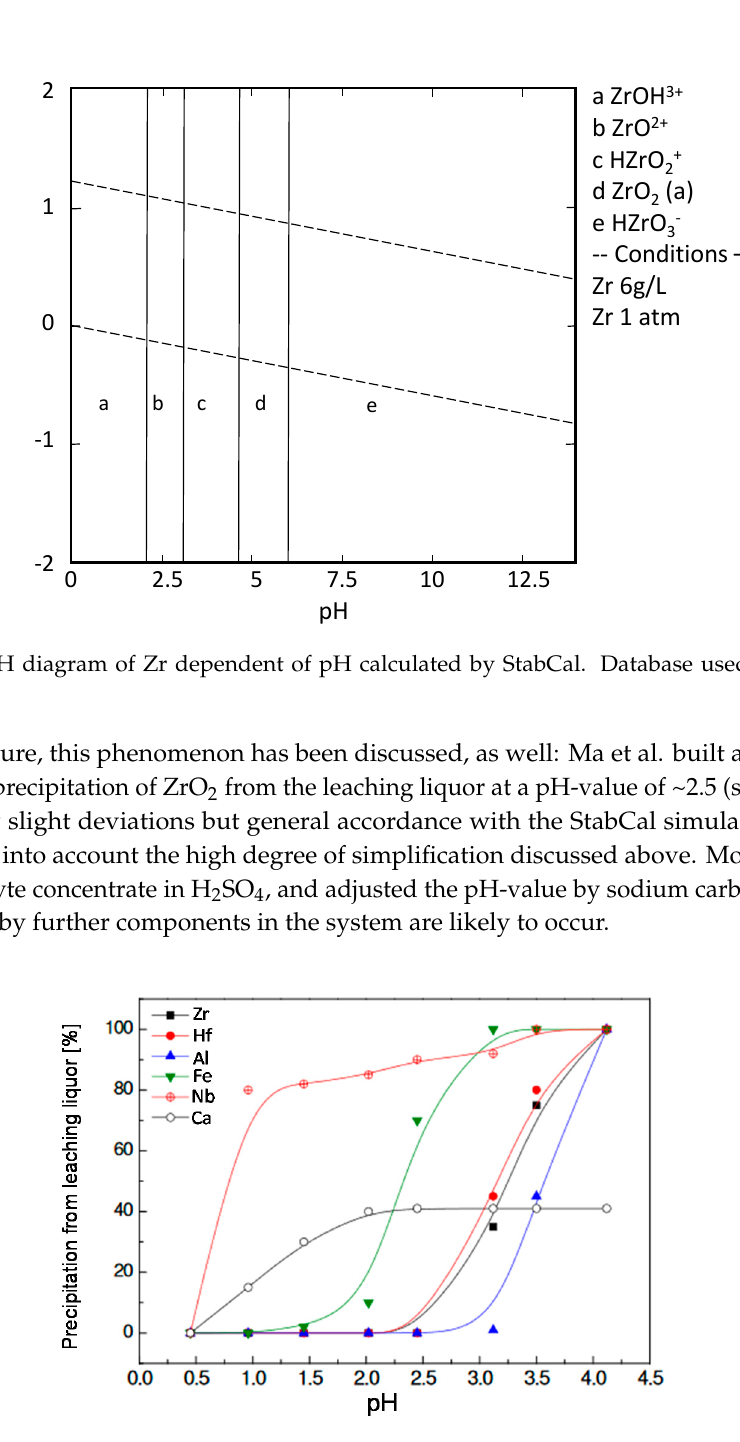
Figure 6. Influence of pH-value in terms of precipitation of Zr stemming from eudialyte from a H 2 SO 4 solution, based on [70].